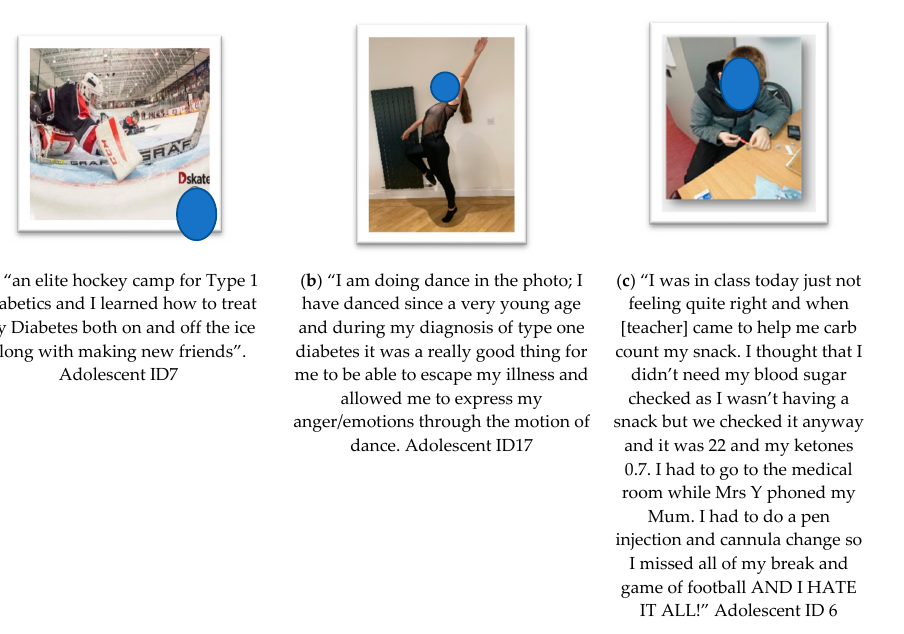
Figure 4. Photovoice submissions representing theme 3— Emotional impact , showing data interpreted as the following sub-themes: ( a ) Confidence through support; ( b ) Resilience & positivity; ( c ) Teen— negative emotions.